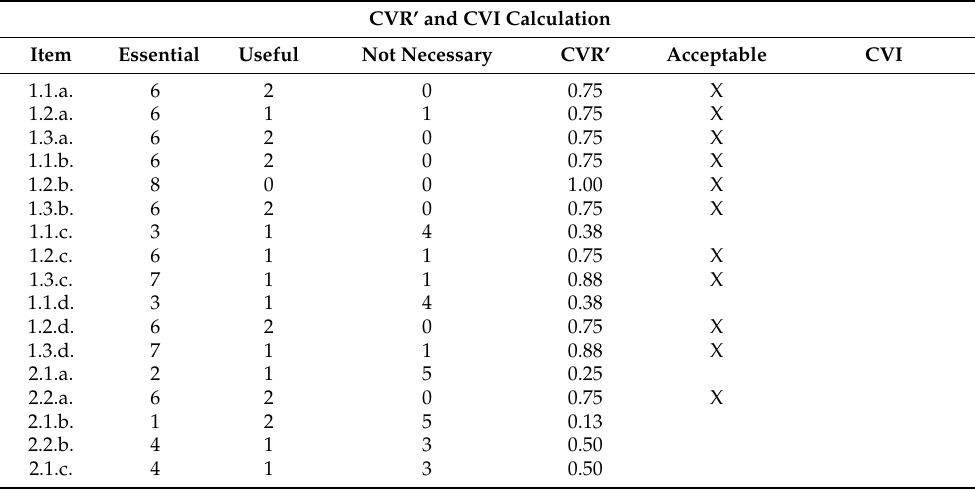
Table A1. CVR’ indices for instrument